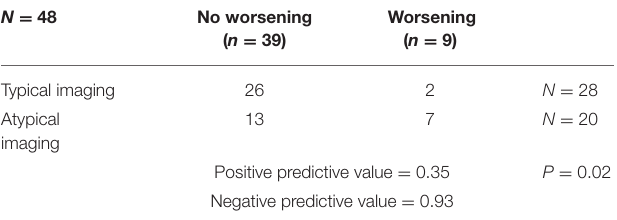
TABLE 2 | Relationship between clinical parameters and